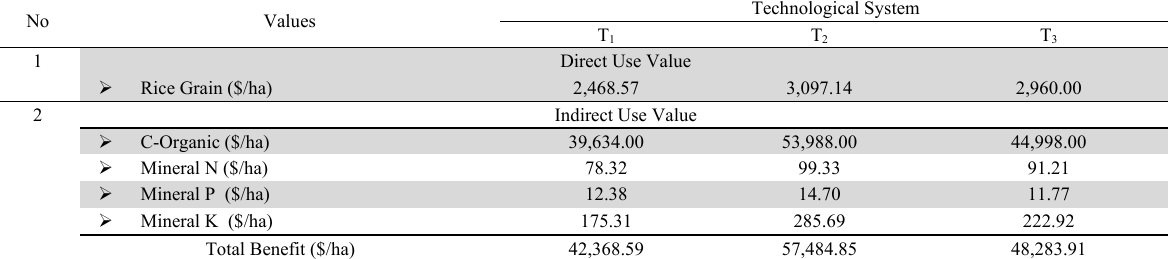
Economic Total Value of Rice Cultivation Component per